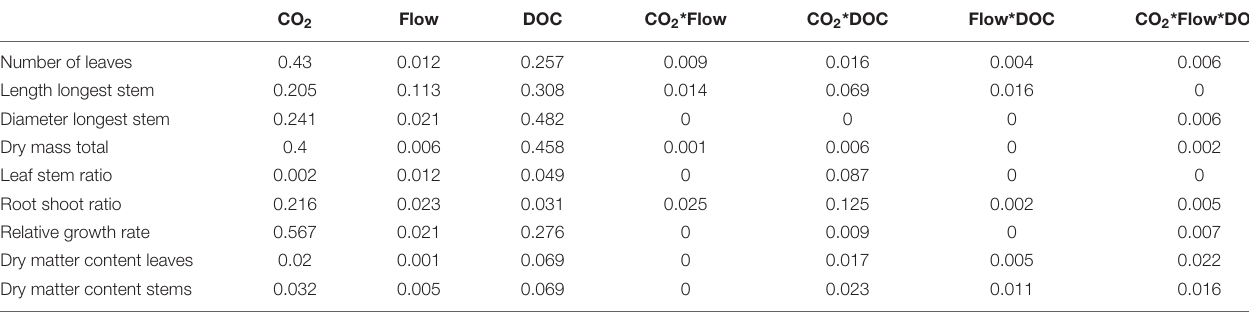
TABLE 3 | Omega squared values for the growth and morphological parameters ( n = 48).